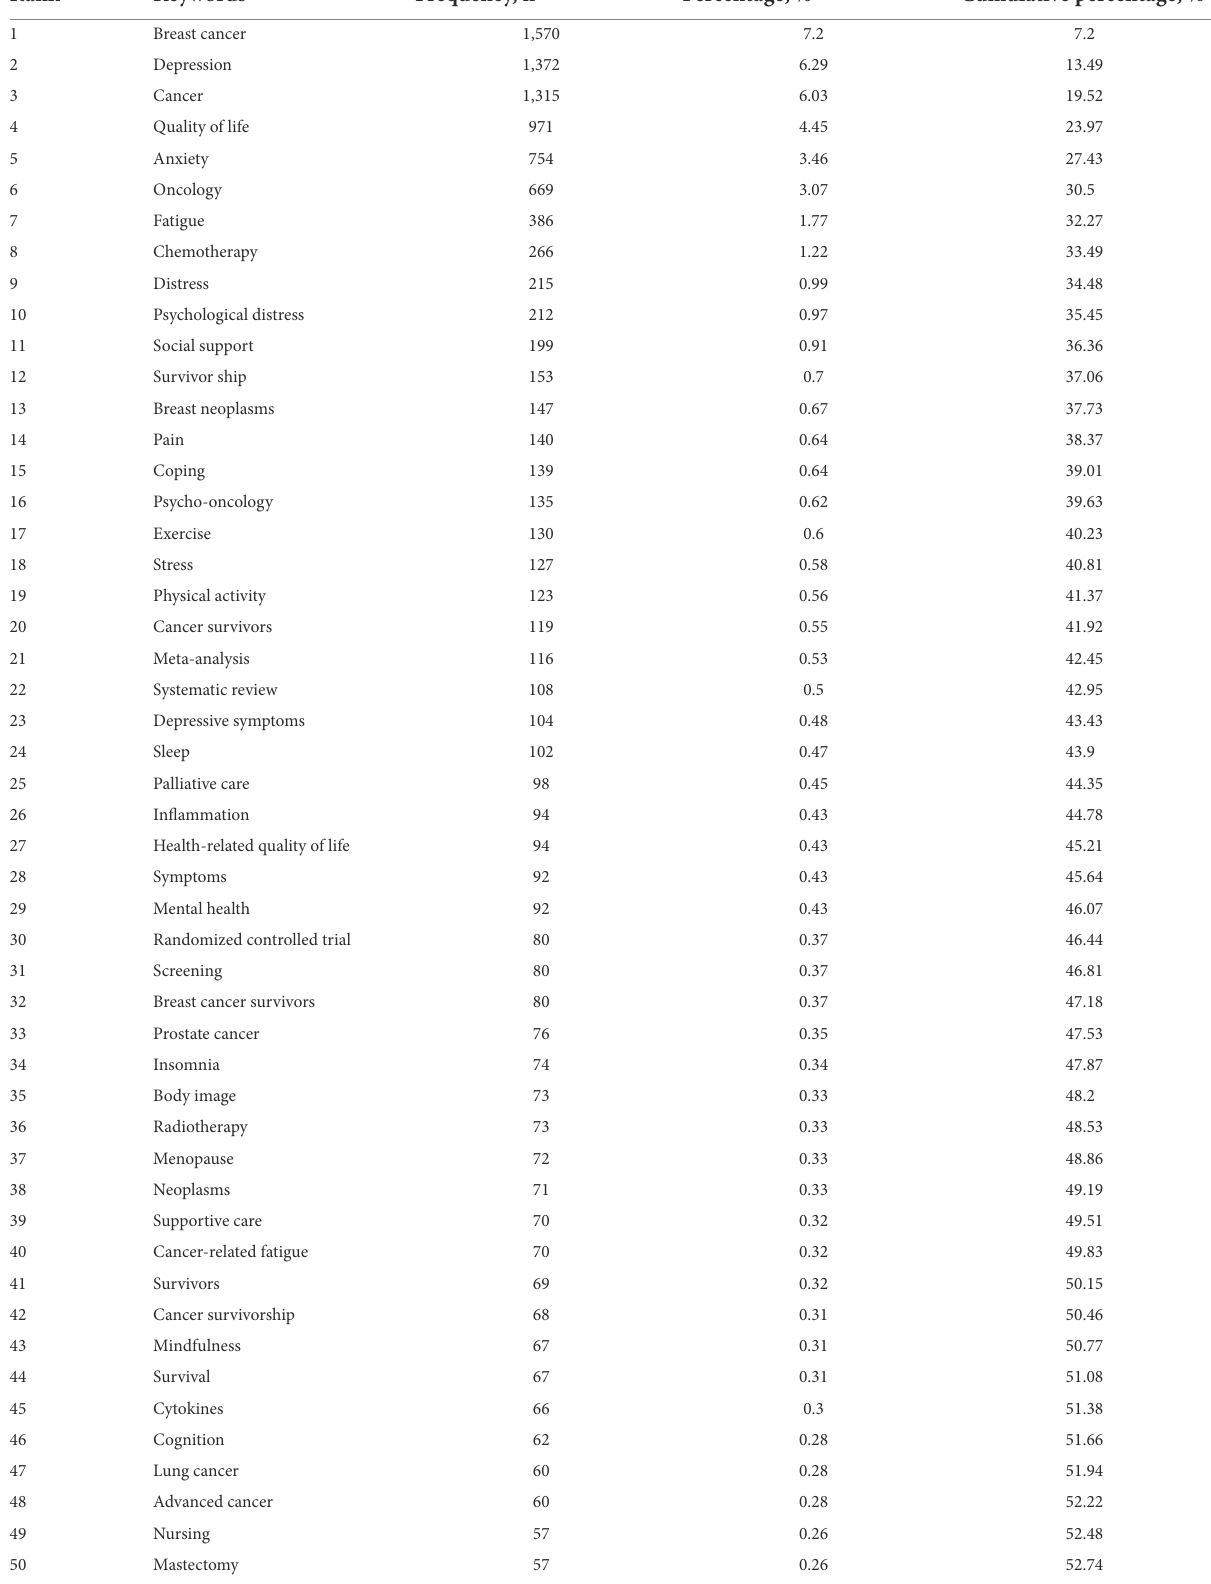
TABLE 4 High-frequency keywords in the studies of depression in breast